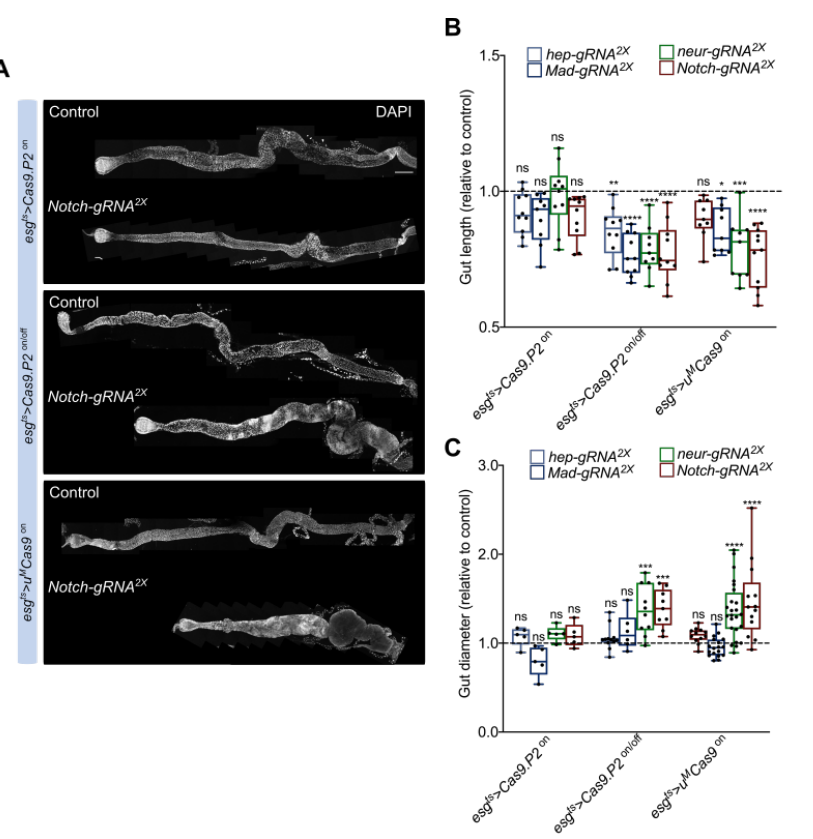
Figure 5. Intestinal morphology changes after perturbing BMP, Notch, and JNK signaling. ( A ) The intestine was imaged and stitched together to visualize morphological changes after perturbing the BMP, Notch, and JNK pathways. Notch perturbations are used as an example to depict intestinal length shortening. Notice clusters of DAPI + nuclei when using Cas9.P2 on/off or u M Cas9 on with Notch gRNA 2x . ( B ) Quantification of intestinal length relative to the control. Intestinal length was shorter when the BMP, Notch, and JNK pathways were perturbed using Cas9.P2 on/off or u M Cas9 on , but not with Cas9.P2 on . ( C ) quantification of the diameter (R4 region) of the intestine relative to the control. Gut diameter increased when Notch signaling were perturbed using Cas9.P2 on/off or u M Cas9 on , but not with Cas9.P2 on . Scale bar: 350 µm. * p < 0.05, ** p < 0.01, *** p < 0.001, **** p <